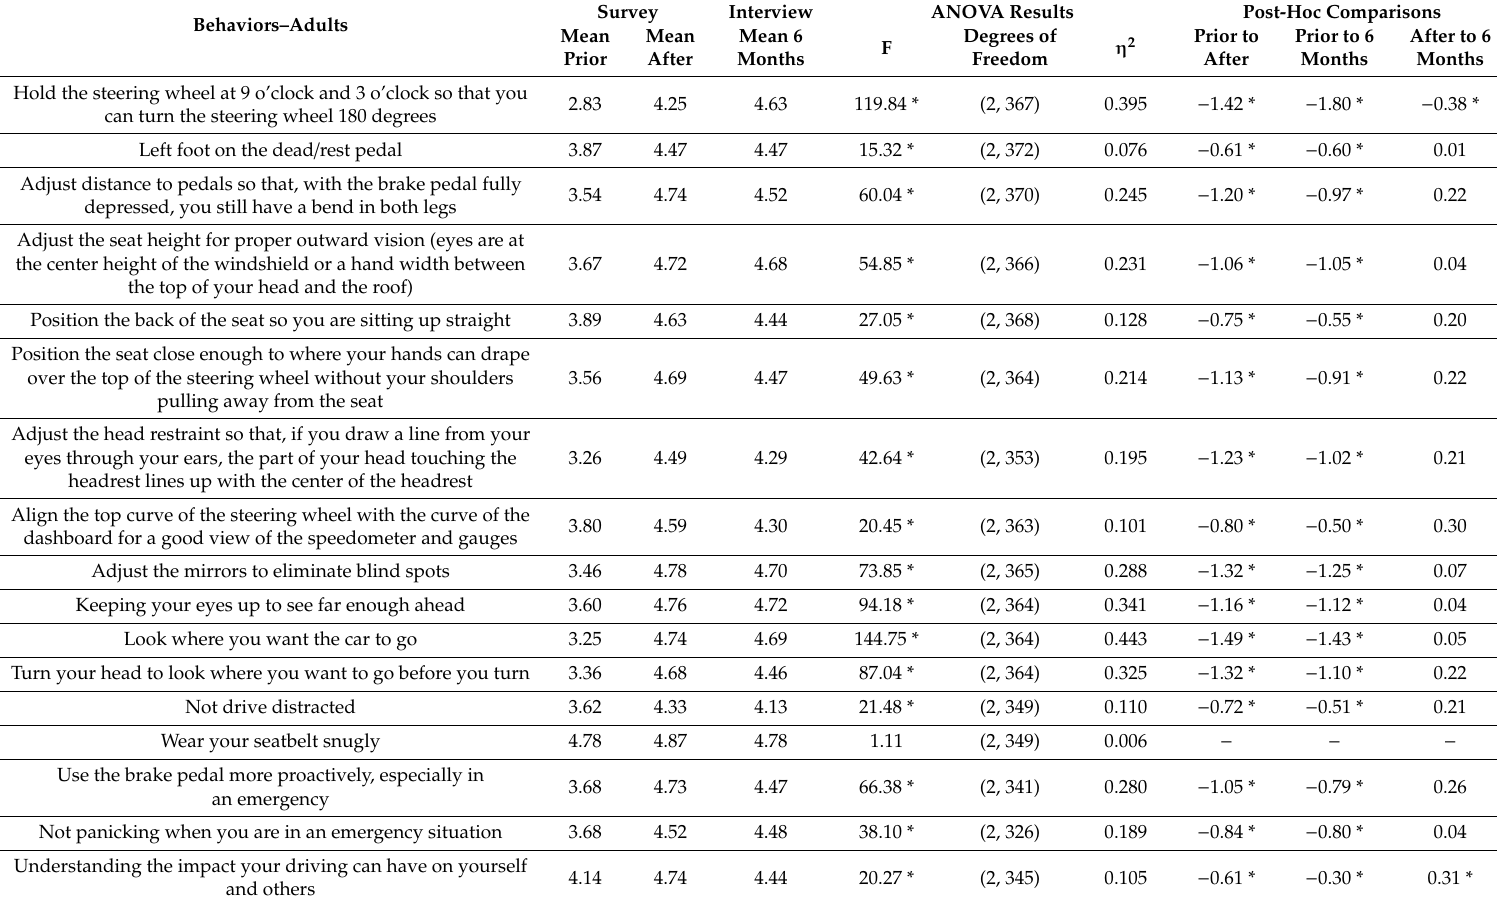
Table 5. Adult survey and phone interview participants’ average ratings of the frequency to exhibit behaviors prior to the class, directly after the class and, for the adults, 6 months after the class. The asterisk designates significant di ff erences ( p <